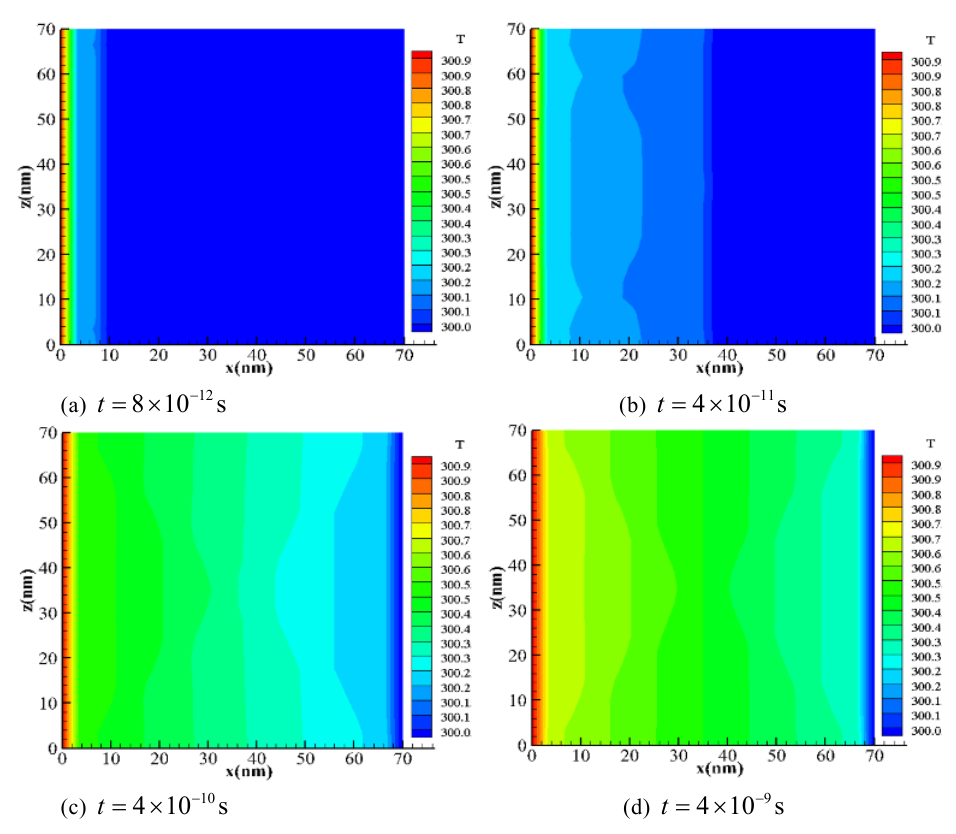
Fig. 4. Different t diffuse reflection boundary temperature